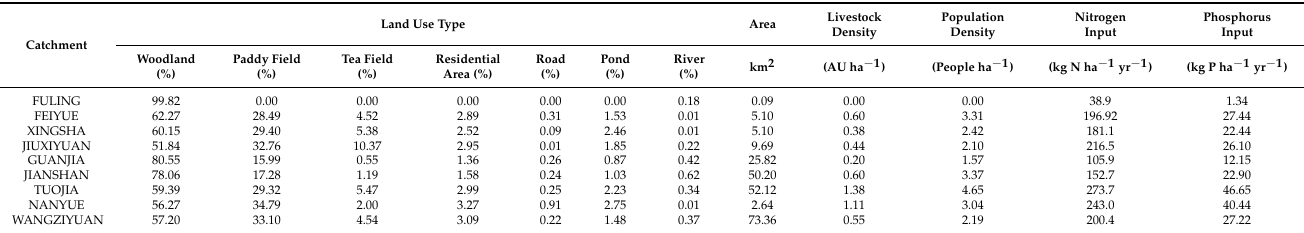
Table 1. Background information of the nine studied